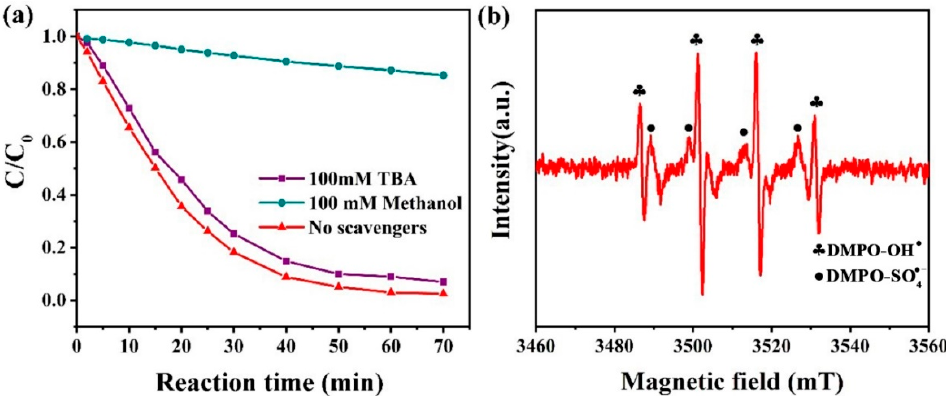
Figure 6. ( a ) The effect of different free radical scavengers on PNP degradation in Co-ZIF@GEL/PMS system ( b ) EPR spectrum of PMS activated by Co-ZIF@GEL within one minute (condition: Co-ZIF@GEL = 100 mg/L, PMS = 1 mM, PNP = 10 mg/L, T = 25 ℃ ;).